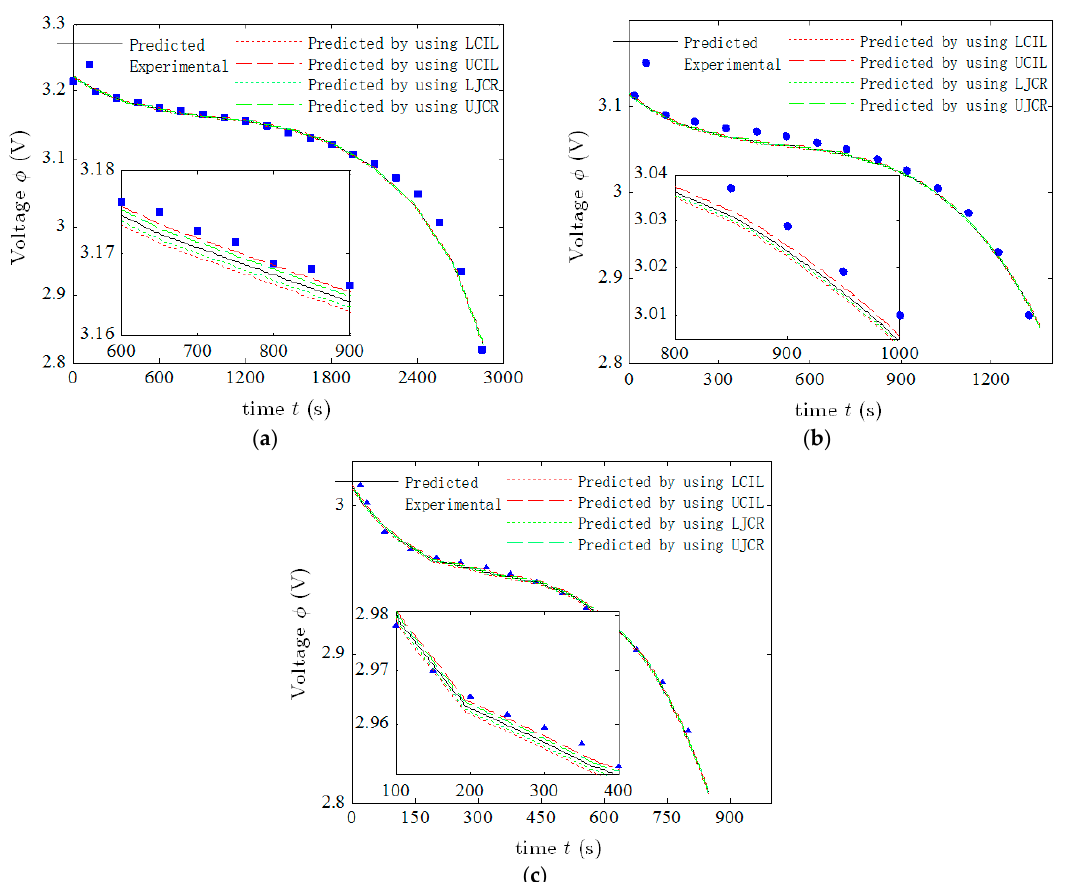
Figure 8. Comparison of the predicted voltage curves at different discharge rates ( a ) 1C; ( b ) 2C; ( c ) 3C, using different limits of the parameter x 1 from the 95% confidence interval and 95% joint confidence region. Point estimates obtained from the simultaneous fit were used for the rest parameters. LCIL and UCIL represent the lower and upper confidence interval limits, respectively; LJCR and UJCR represent the lower and upper joint confidence region limits, respectively. The confidence region of